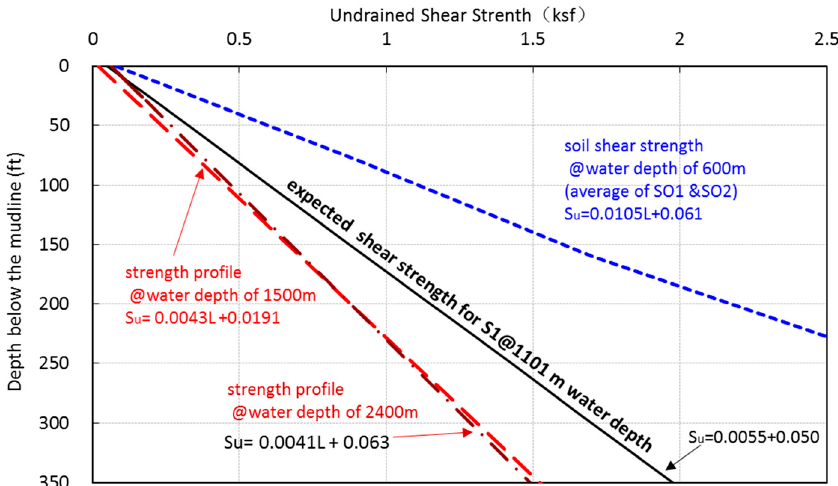
Figure 3. Shallow soil undrained shear strength under different water depth.